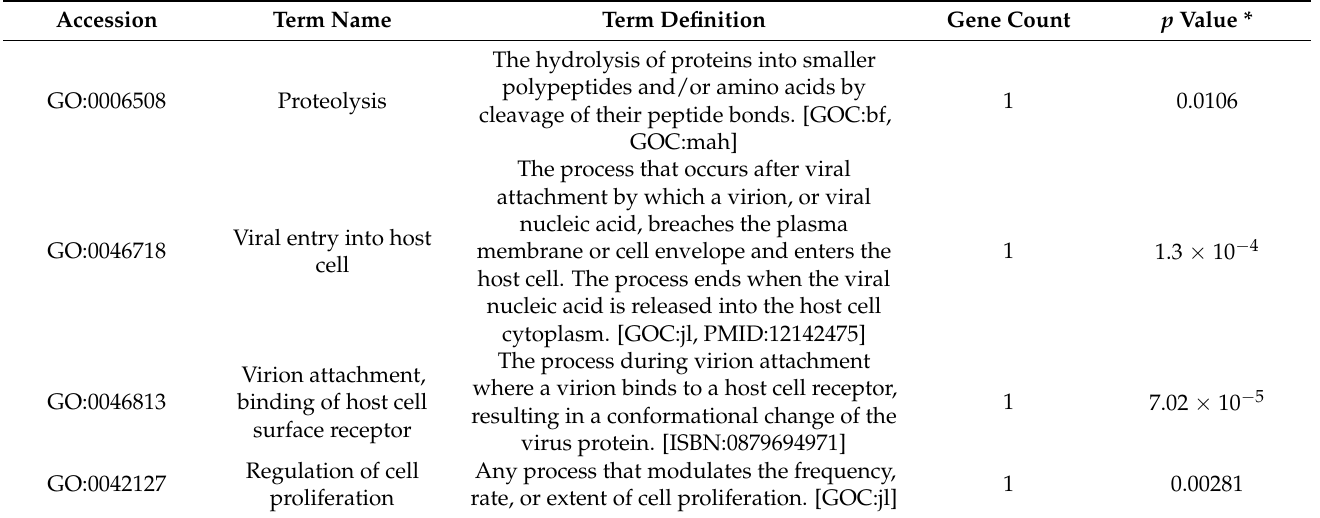
Figure 1. Transcription binding sites in the promoter of ACE2 and overlapping of type I and type II IFNs pathways in the regulation of ACE2. ( A ). Using www.interferome.org, we generated transcription binding sites in promoter region of ACE2. The location of the transcription factors on each of the genes from the region spanning − 1500 bp to + 500 bp from the start site. Each coloured box represents a specific transcription factor, the key for which is provided below the graphic. TRANSFAC* predicted a match between the transcription factor and its predicted binding site [34]. ( B ). The Venn diagram shows the number of genes regulated by one or more IFN type (Type I, II or III). It should be noted that there are far more datasets for genes regulated by type I than for types II or III; this imbalance introduces the risk of false negatives and bias for the under-represented types II and III. Therefore, caution is encouraged in interpreting low or negative results from these types. Table 1. Gene Ontology (GO) Analysis (Biological Process) of